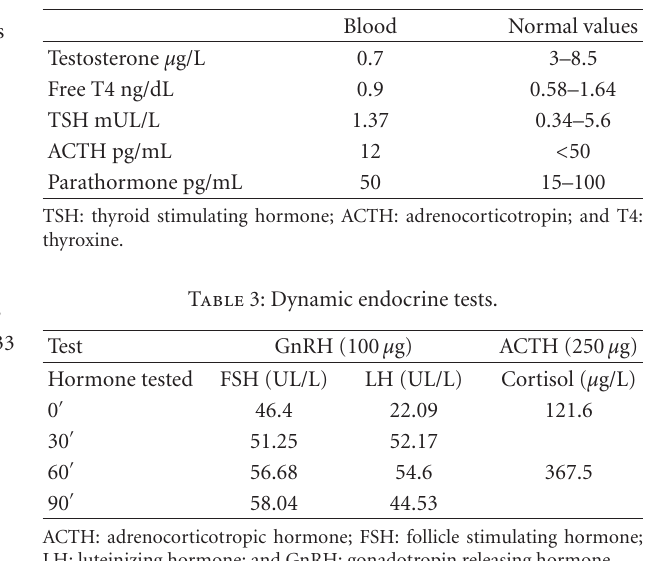
Table 1: Biological data. Table 2: Hormonal data.